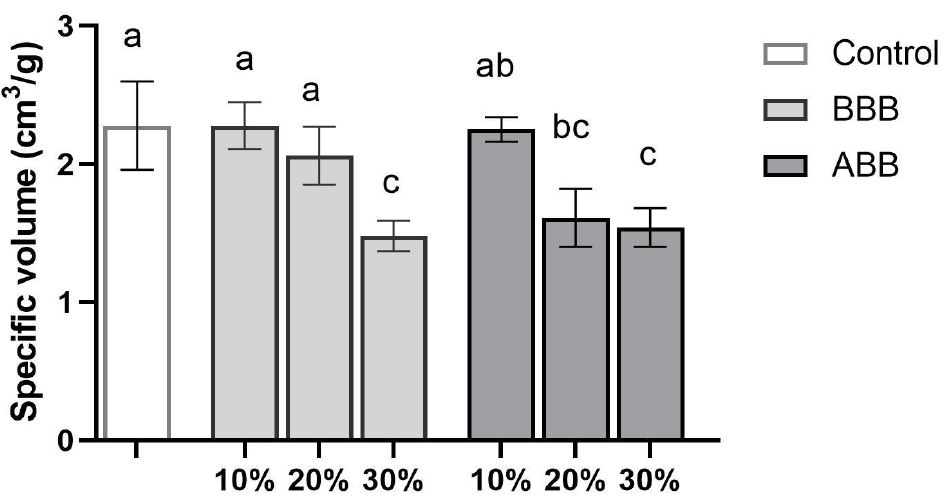
Figure 2. The volume of control bread and breads added with black bean and ayocote bean. BBB: Bread with black beans and ABB: Bread with ayacote beans.